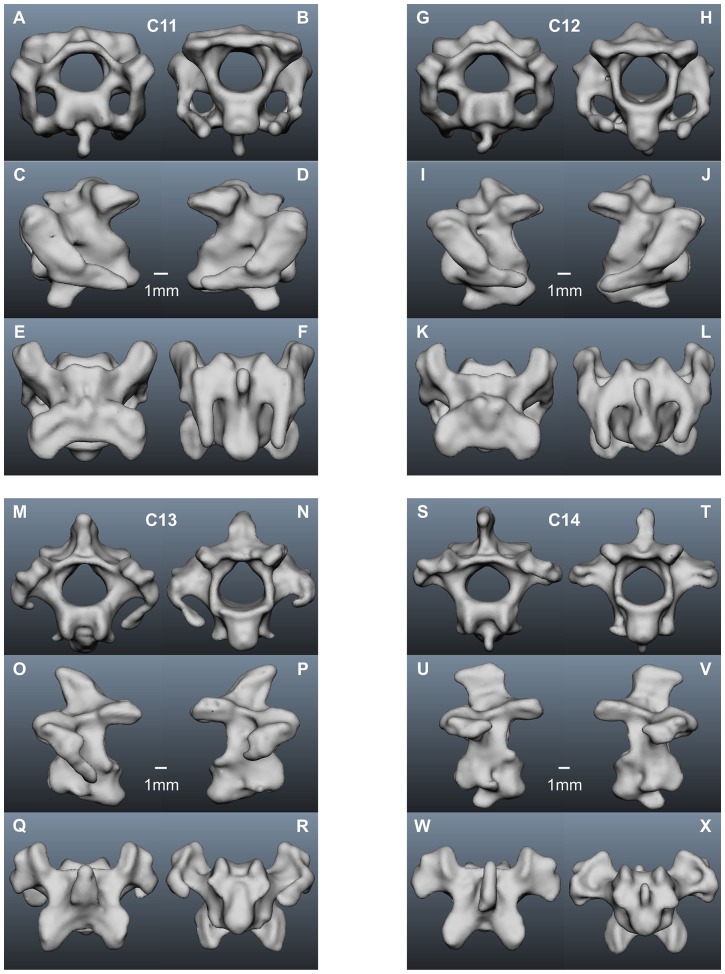
Cervical vertebrae of the American barn owl III.A–F) 11th cervical vertebra; G–L) 12th cervical vertebra; M–R) 13th cervical vertebra; S–X) 14th cervical vertebra. For further explanations see legends to Figures 1 and 6.